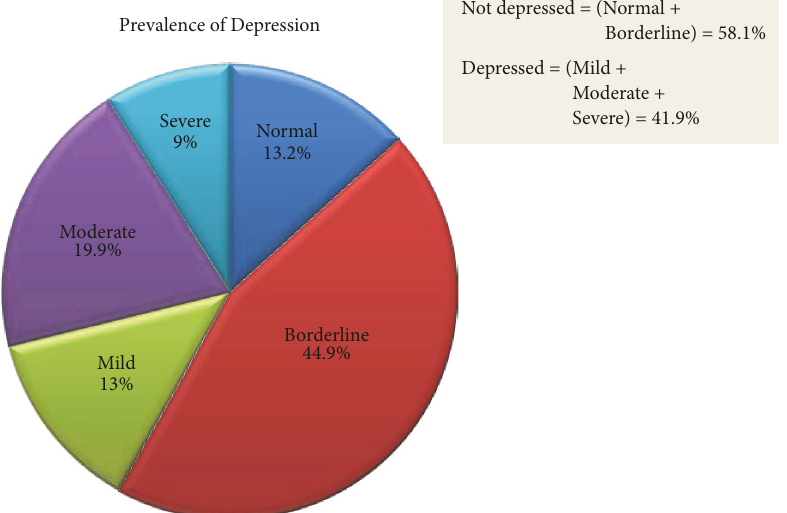
Figure 2: Levels of depression and its prevalence among prisoners in Jimma town Correctional Institution, June, 2017. 𝑁 = 332